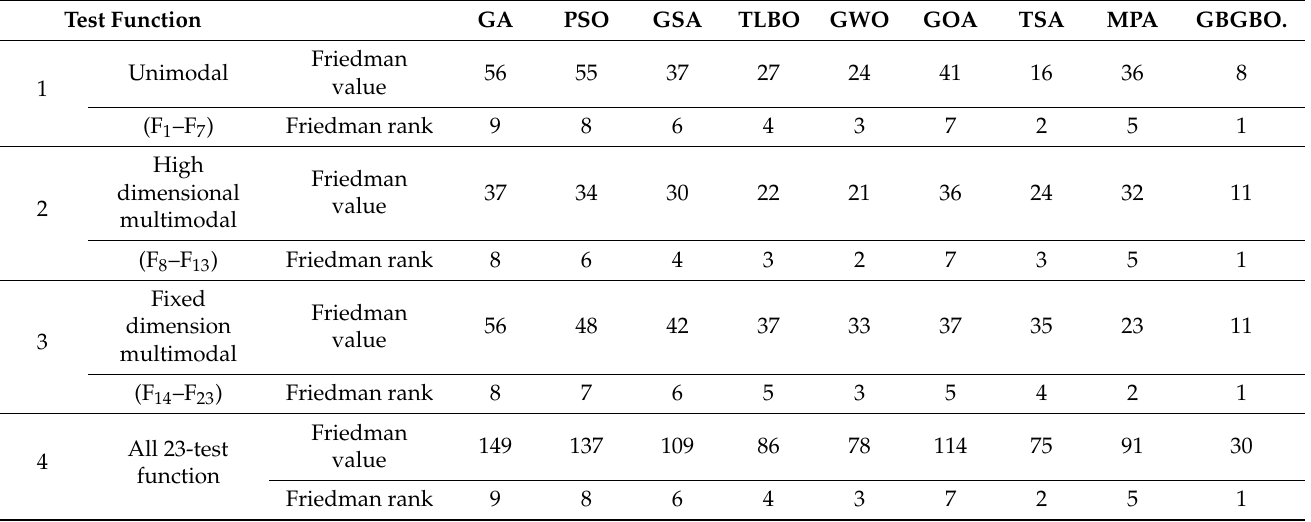
Table 5. Results of Friedman rank